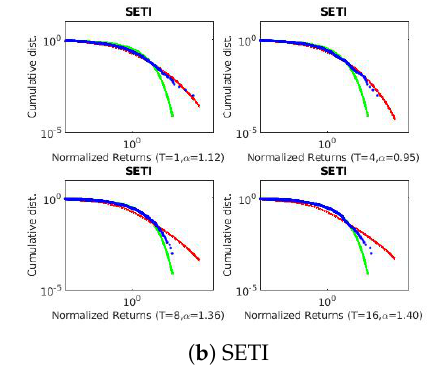
Figure A1. Lévy model fits for PSI and SETI.